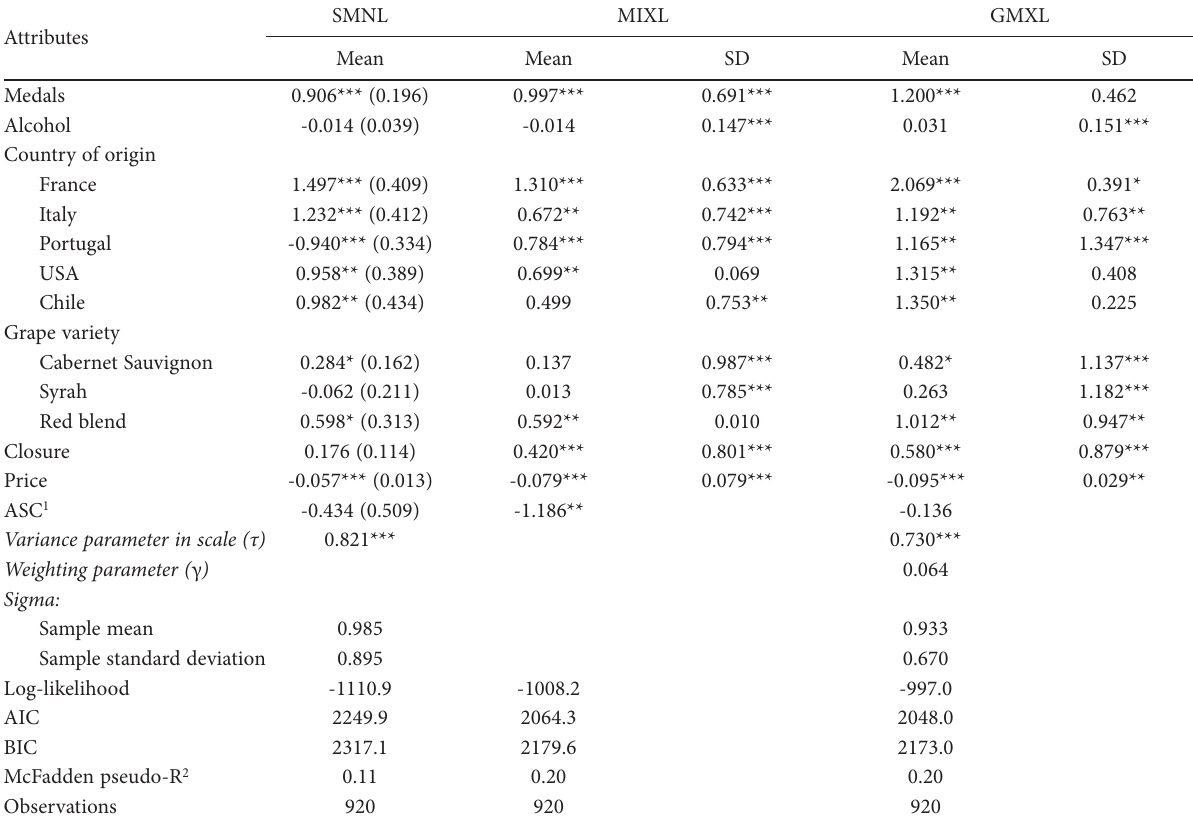
Table 3. Results from SMNL, MIXL and GMXL